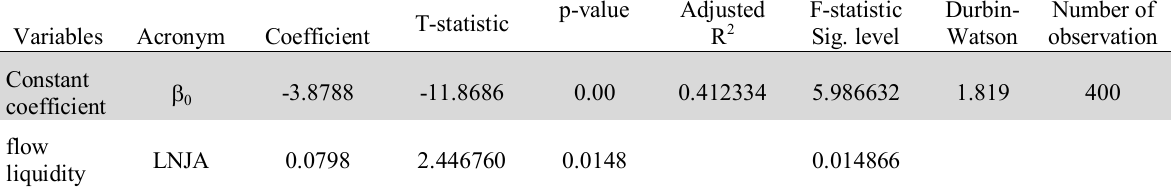
p-value Adjusted T-statistic Sig. level observation